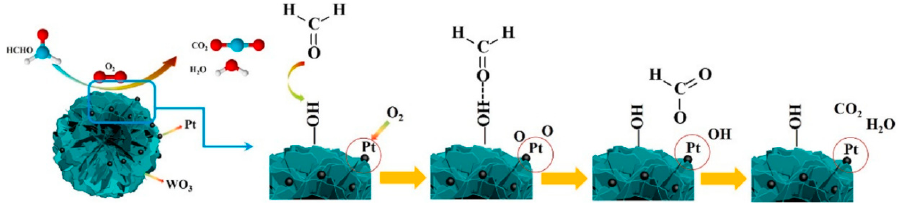
Figure 6. Possible mechanism of HCHO decomposition on the Pt/WO 3 catalysts [66].